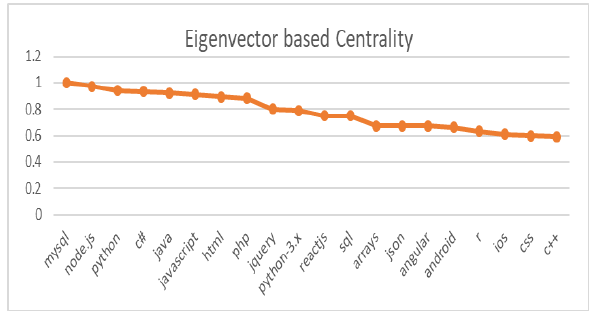
Figure 19. Eigenvector based